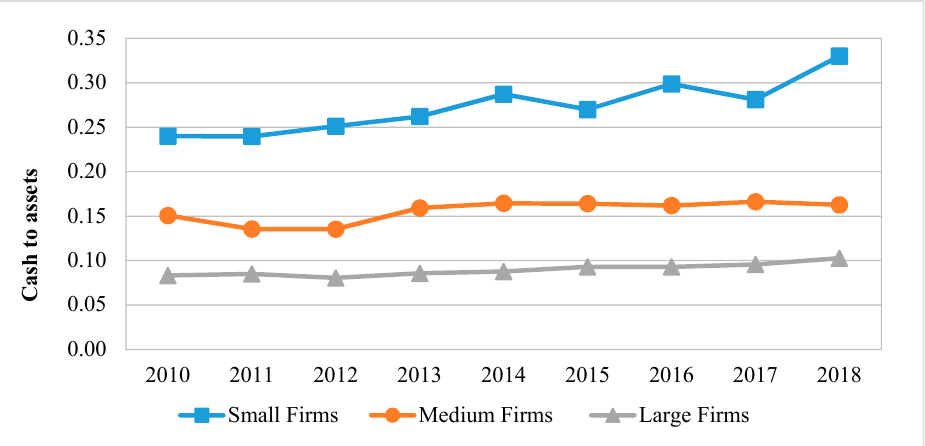
Figure 3. Firms’ cash holdings over size. Note: This figure plots the evolution of the average cash to asset ratio over time for small, medium, and large-sized UK non-financial non-utility firms during 2010–2018.